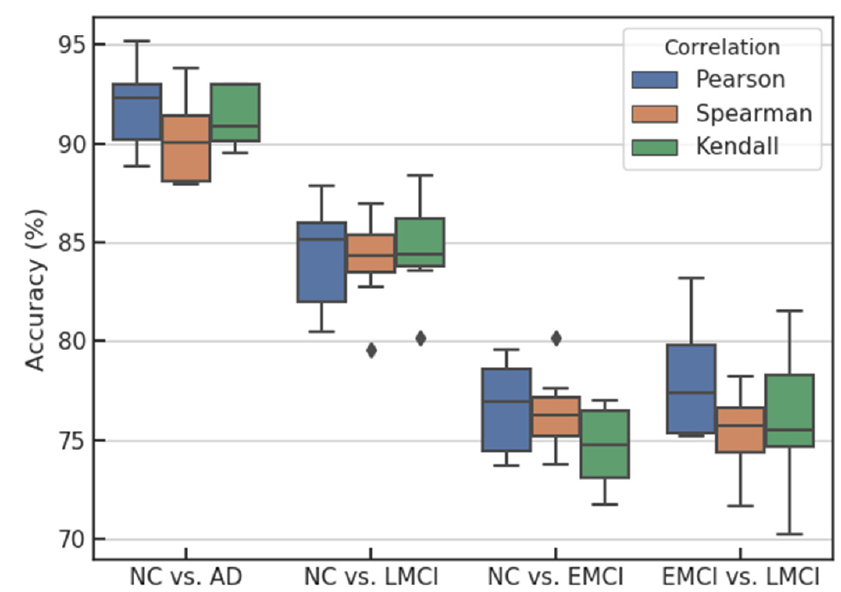
Figure 5. Influence of correlation coefficient calculation on classification accuracy.